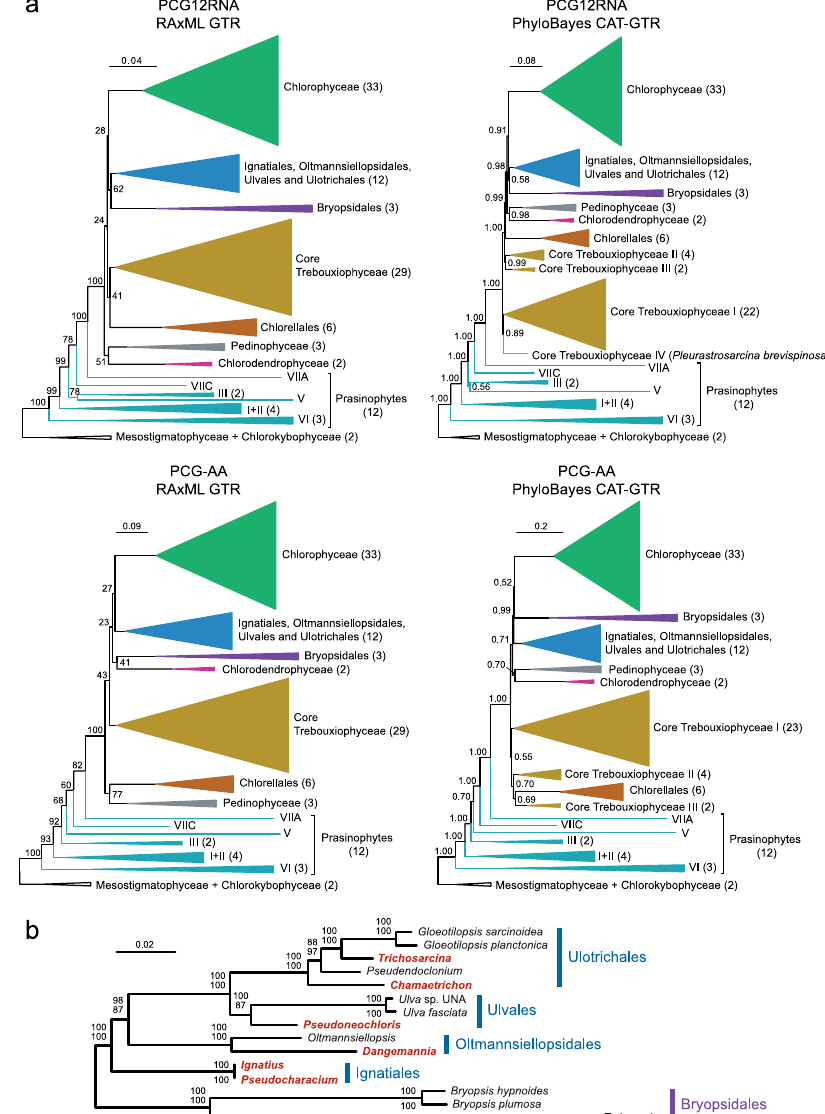
Figure 2. Chloroplast phylogenomic trees of chlorophytes inferred from the PCG-AA and PCG12RNA data sets using RAxML and PhyloBayes. ( a ) Relationships among the major lineages of the Chlorophyta. Strongly supported clades are represented as triangles with sizes proportional to the number of taxa (indicated in parentheses). Bootstrap support and posterior probability values are reported on the nodes. ( b ) Relationships among ulvophycean taxa. The best-scoring RAxML tree inferred from the PCG12RNA data set is presented. Bootstrap support values are reported on the nodes: from top to bottom are shown the values for the RAxML analyses of the PCG12RNA and PCG-AA data sets. The names of the newly examined taxa are indicated in